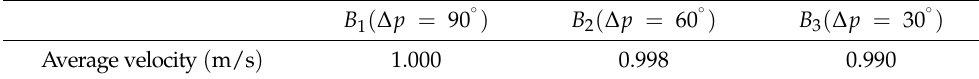
Table 3. Average velocities in different phase conditions.